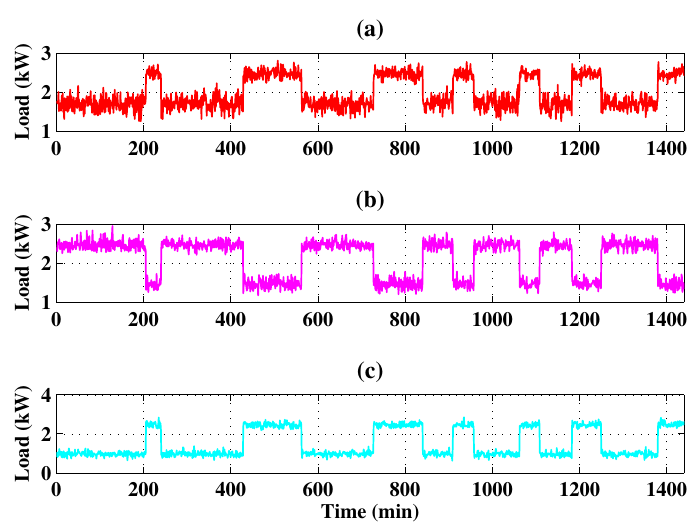
Figure 1. Stochastic load at a Patrol Base microgrid for ( a ) Tier 1; ( b ) Tier 2; and ( c ) Tier 3